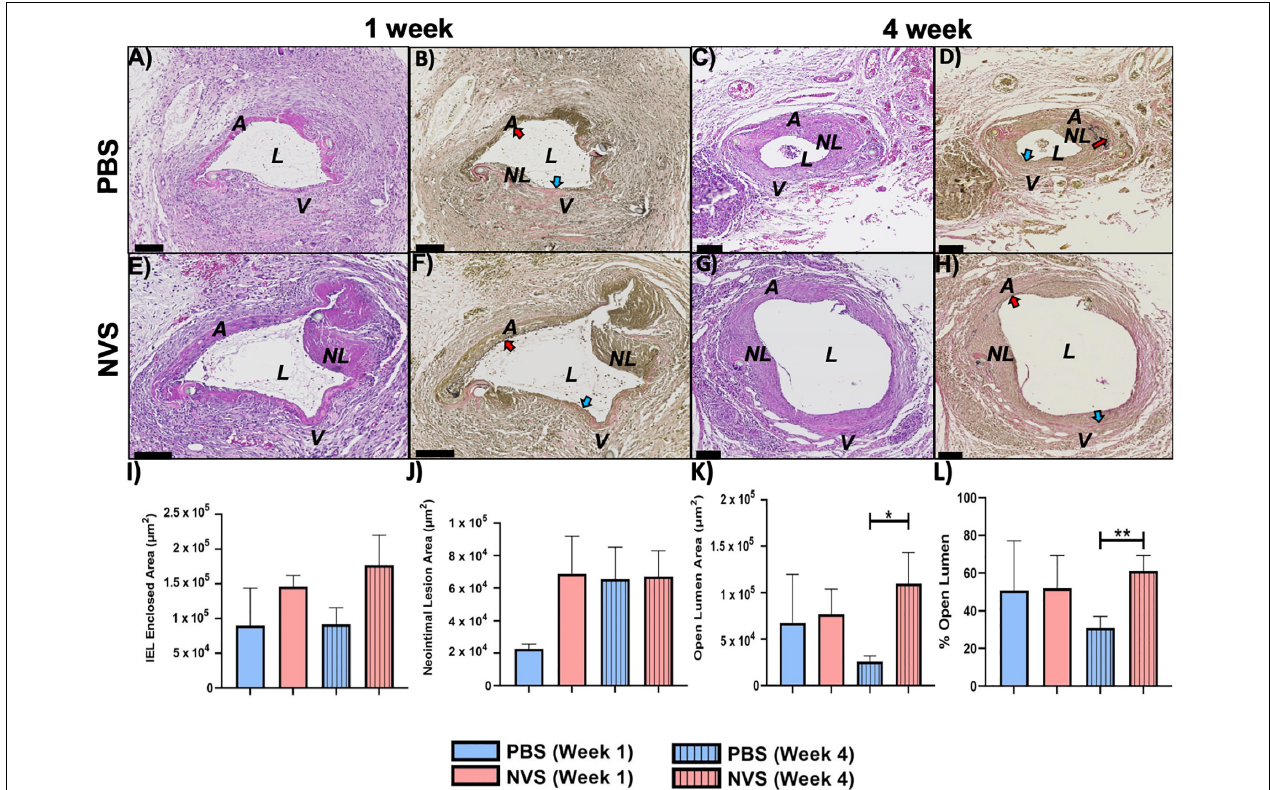
FIGURE 2 | AVF anastomoses. Representative images of H&E (A,C,E,G) and VVG (B,D,F,H) staining of the AVF anastomoses at 1 week (A,B,E,F) and 4 weeks (C,D,G,H) from animals treated with PBS (A–D) and NVS (E–H) . (I–L) Morphometric analysis of the venous limb of the AVF anastomosis. Results are presented as average ± standard error of mean. N = 3–4 per group in week 1. N = 6–9 per group in week 4. * p < 0.05. ** p < 0.01. Scale bar = 100 µ m. A, arterial limb of AVF; V, venous limb of AVF; L, lumen; NL, neointimal lesion. Red and blue arrows indicate the internal elastic laminae of the arteries and veins,